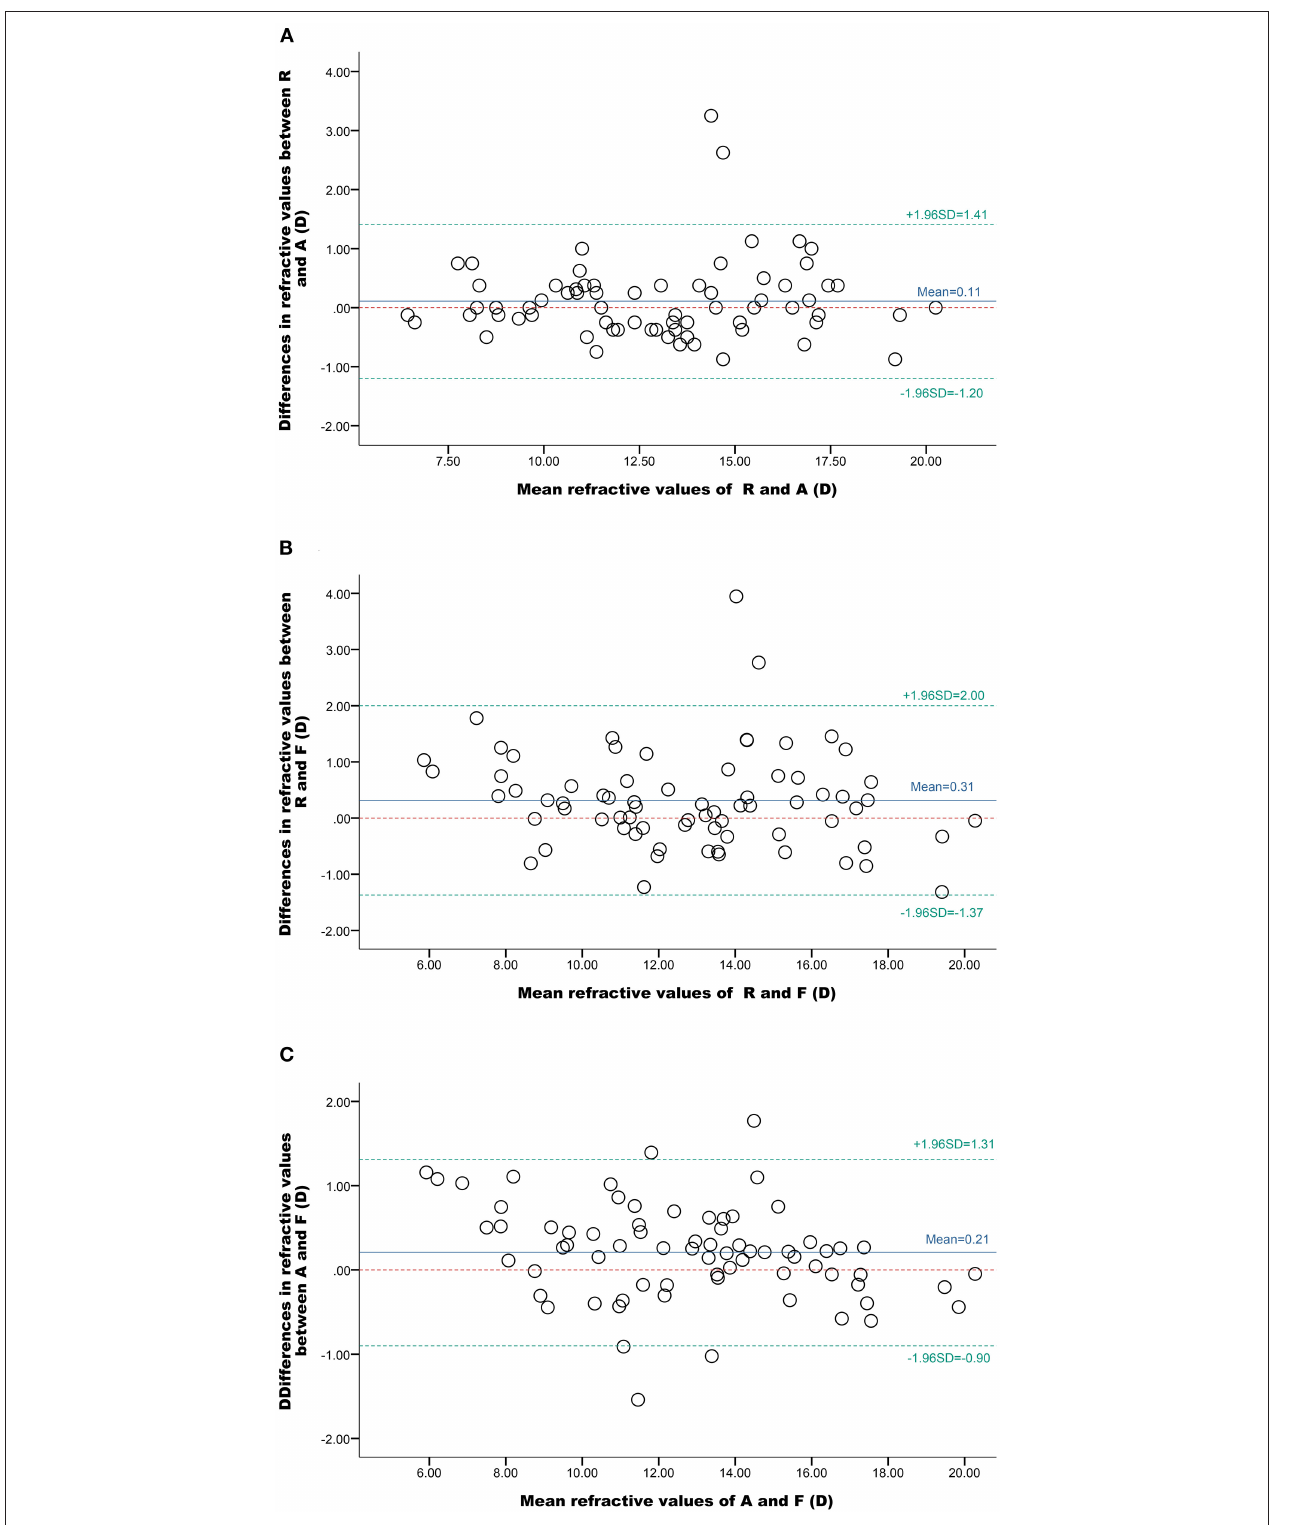
FIGURE 4 | Bland-Altman plots of the spherical equivalent refractive values obtained using different methods. The solid blue lines represent the observed mean agreement between the methods, the dashed green lines represent the 95% limits of agreement, and the red, dashed, horizontal lines represent the perfect mean agreement between the methods. (A) Comparison of values determined using a refractometer (R) and an automatic refractor meter (A), (B) a refractometer (R) and the vergence formula (F), and (C) an automatic refractor meter (A) and the vergence formula (F).